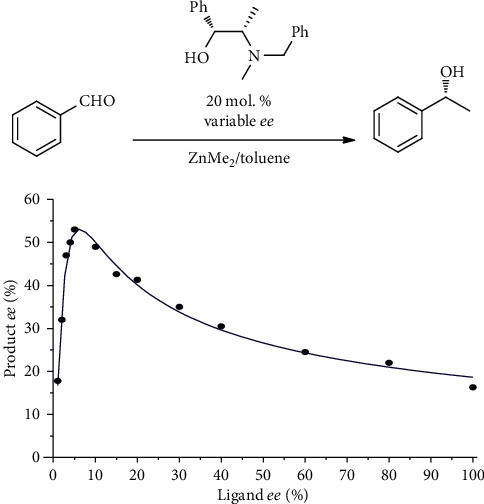
Nonconventional nonlinear effect (NLE) in the (-)-NBE-catalyzed addition of ZnMe2 to benzaldehyde.